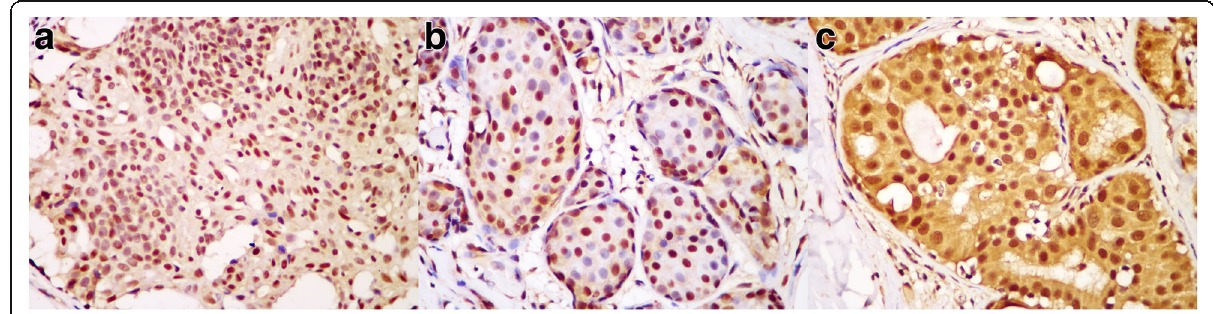
Fig. 1 Representative cases of FOXP1 expression in UDH and ADH. FOXP1 positive staining was located in the nuclei of ductal cells in UDH ( a ×400). In ADH, FOXP1 positivity was observed in the nuclei of tumor cells ( b ×400) or in both the nuclei and the cytoplasm ( c